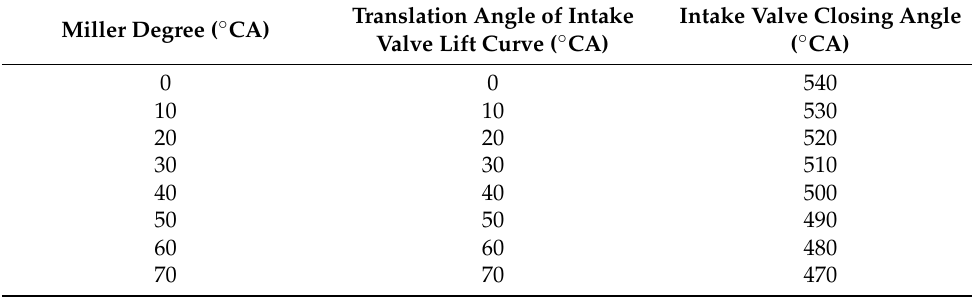
Table 8. Overlapping angle Miller cycle scheme of the variable gas valve.